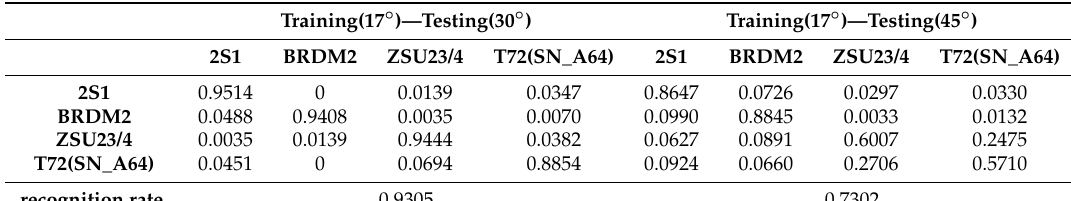
Table 19. The result of SRC based on SAR-HOG under EOC_d.